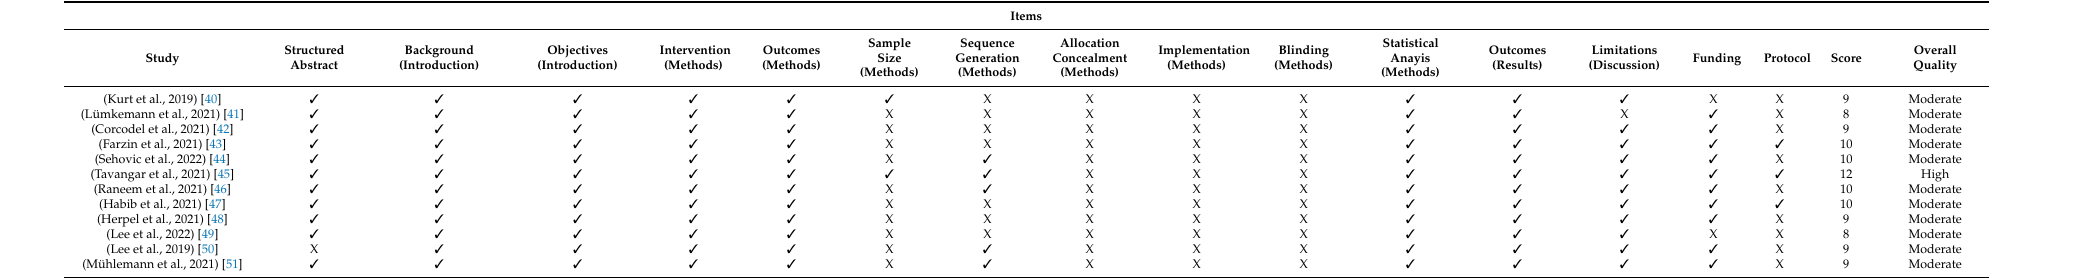
Table 3. Quality assessment of the included